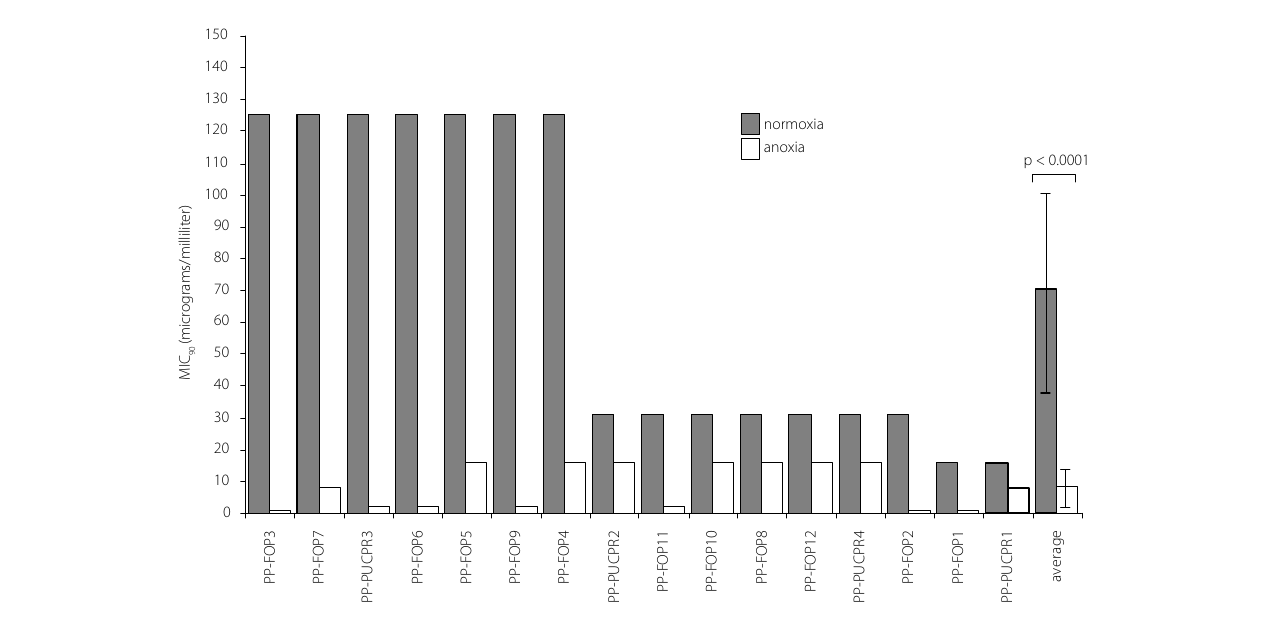
Figure 1. Minimum inhibitory concentration (MIC) of chlorhexidine digluconate for periodontium-related (PP) Candida albicans strains in normoxia and anoxia.